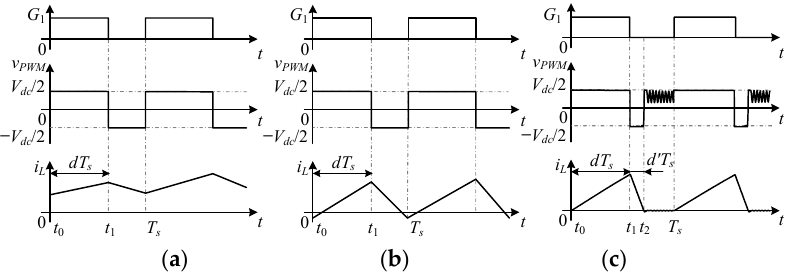
Figure 2. Schematic diagram of different current modes: ( a ) CCM, ( b ) TCM, ( c ) DCM.